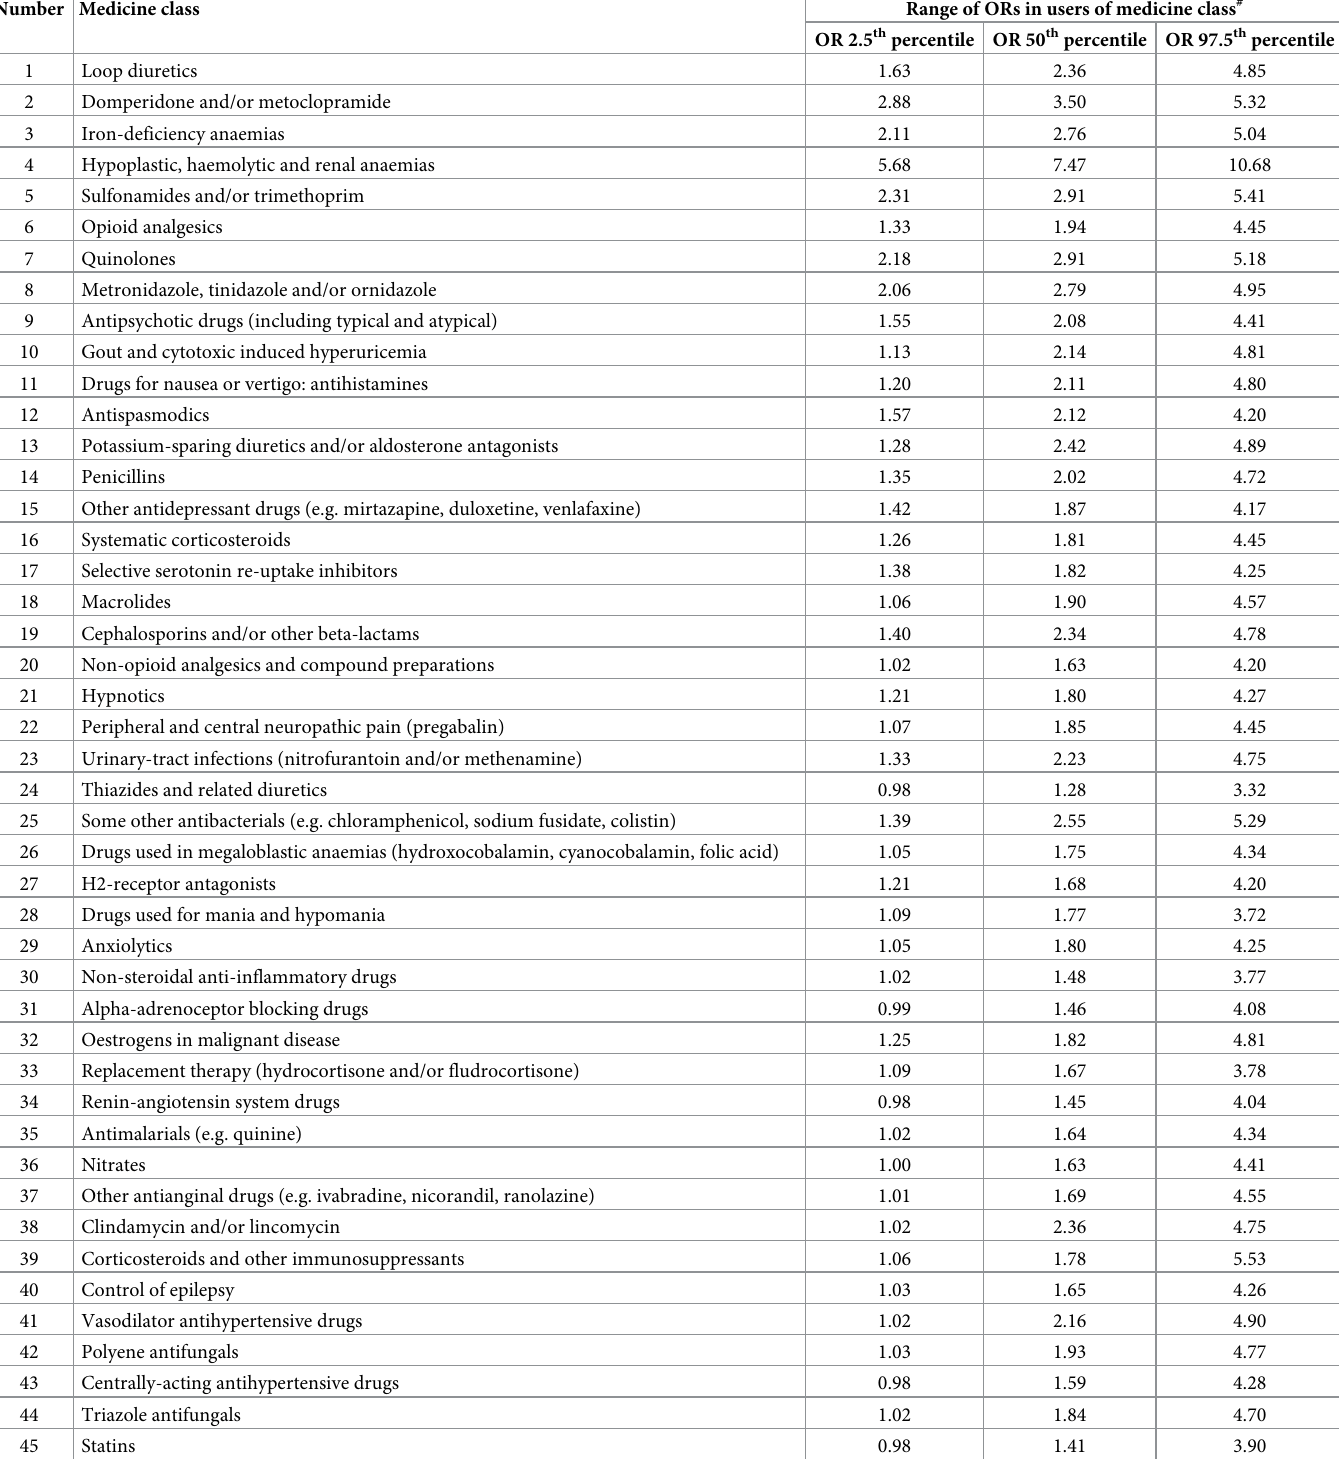
Table 4. Range of ORs for ADR-related hospital admission for various medicine classes based on predictions by random forest models (medicine classes ranked in descending order by variable importance in the random forest models). Number Medicine